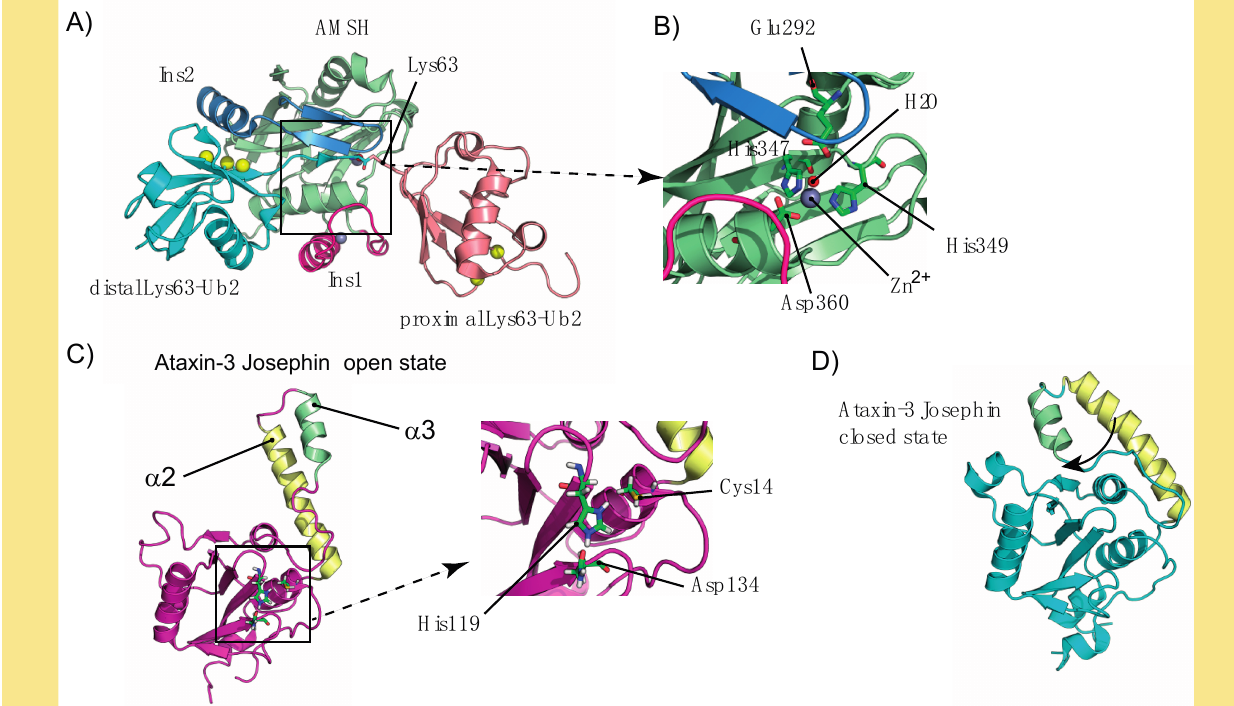
Figure I. ( A ) Structure of the AMSH-LP/K63-Ub complex (PDB code 2ZNV) showing the JAMM core Ins1 and 2 Ins2. The distal and proximal domains of K63-Ub are shown in cyan and pink, respectively, whereas the Ub 2 hydrophobic patch defined by Val70, Ile44 and Leu8 is represented as yellow spheres. ( B ) The inset represents an expanded view of the catalytic region of AMSH and the coordination of the Zn 2+ ion. ( C ) Structure of the open conformation of the Ataxin-3 Josephin domain (PDB code 2JRI), together with an expanded view of the catalytic triad. ( D ) Structure of the closed conformation of the Ataxin-3 Josephin domain (PDB code